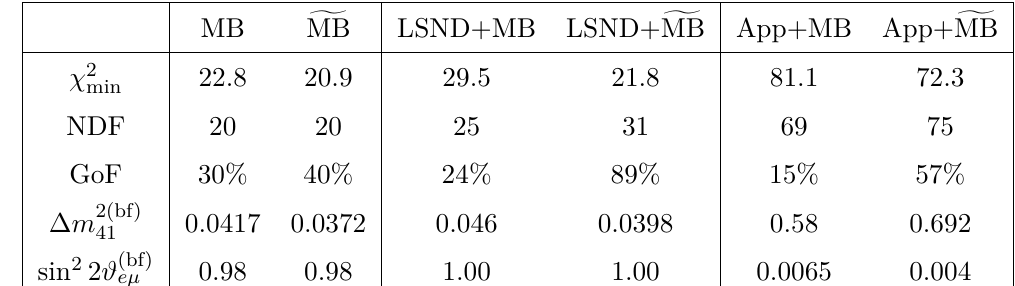
Table 2 . Minimum χ 2 , number of degrees of freedom (NDF) and Goodness of Fit (GoF) of the analyses of the data of short-baseline ( − ) ν µ → ( − ) ν e experiments discussed in the text without (MB) and with ( g MB) our enhanced single- γ background in MiniBooNE. ∆ m 2 (bf) best-fit values of the corresponding oscillation